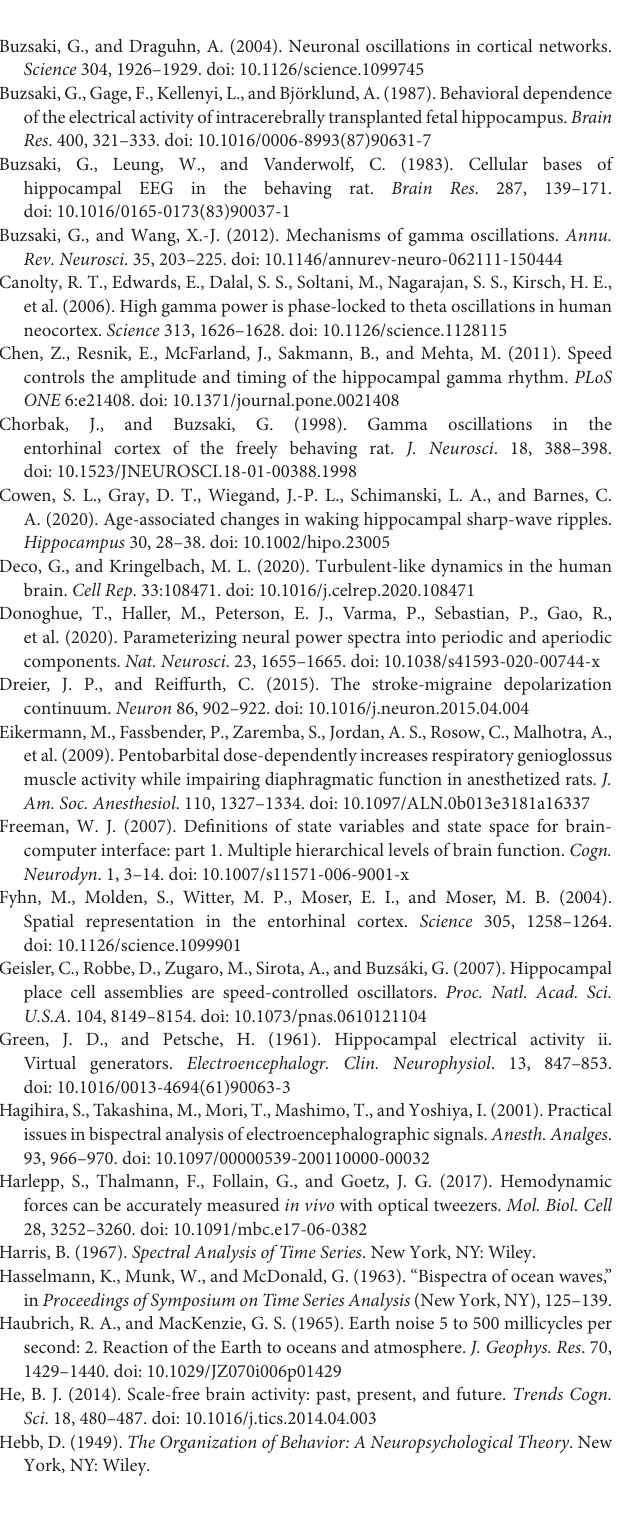
Supplementary Figure 10 | Similar with Figure 3 without cross region coherence and bicoherence. Data from rat 889. Supplementary Figure 11 | Similar with Figure 3 without cross region coherence and bicoherence. Data from rat